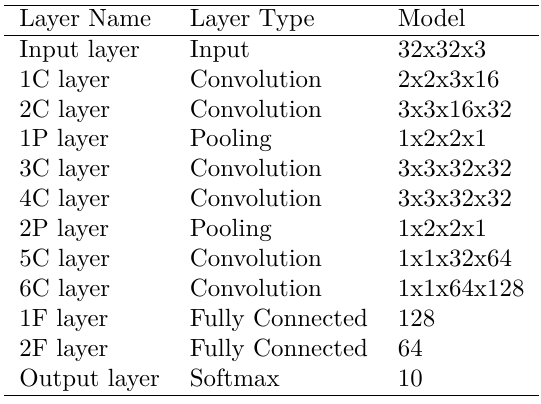
Figure 9: Experimental environment Table 2: CNN model architecture for CIFAR-10